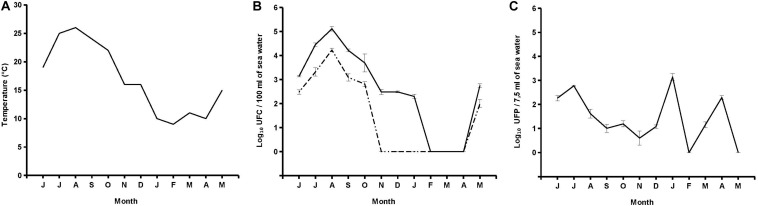
Trend of temperature (A), V. parahaemolyticus and total vibrio
(B), and Halobacteriovorax
(C).